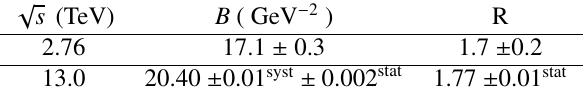
Table 2. Summary of B and R measurements of TOTEM at √ s = 2 . 76 and 13 TeV in pp collisions [1, 3, 4,